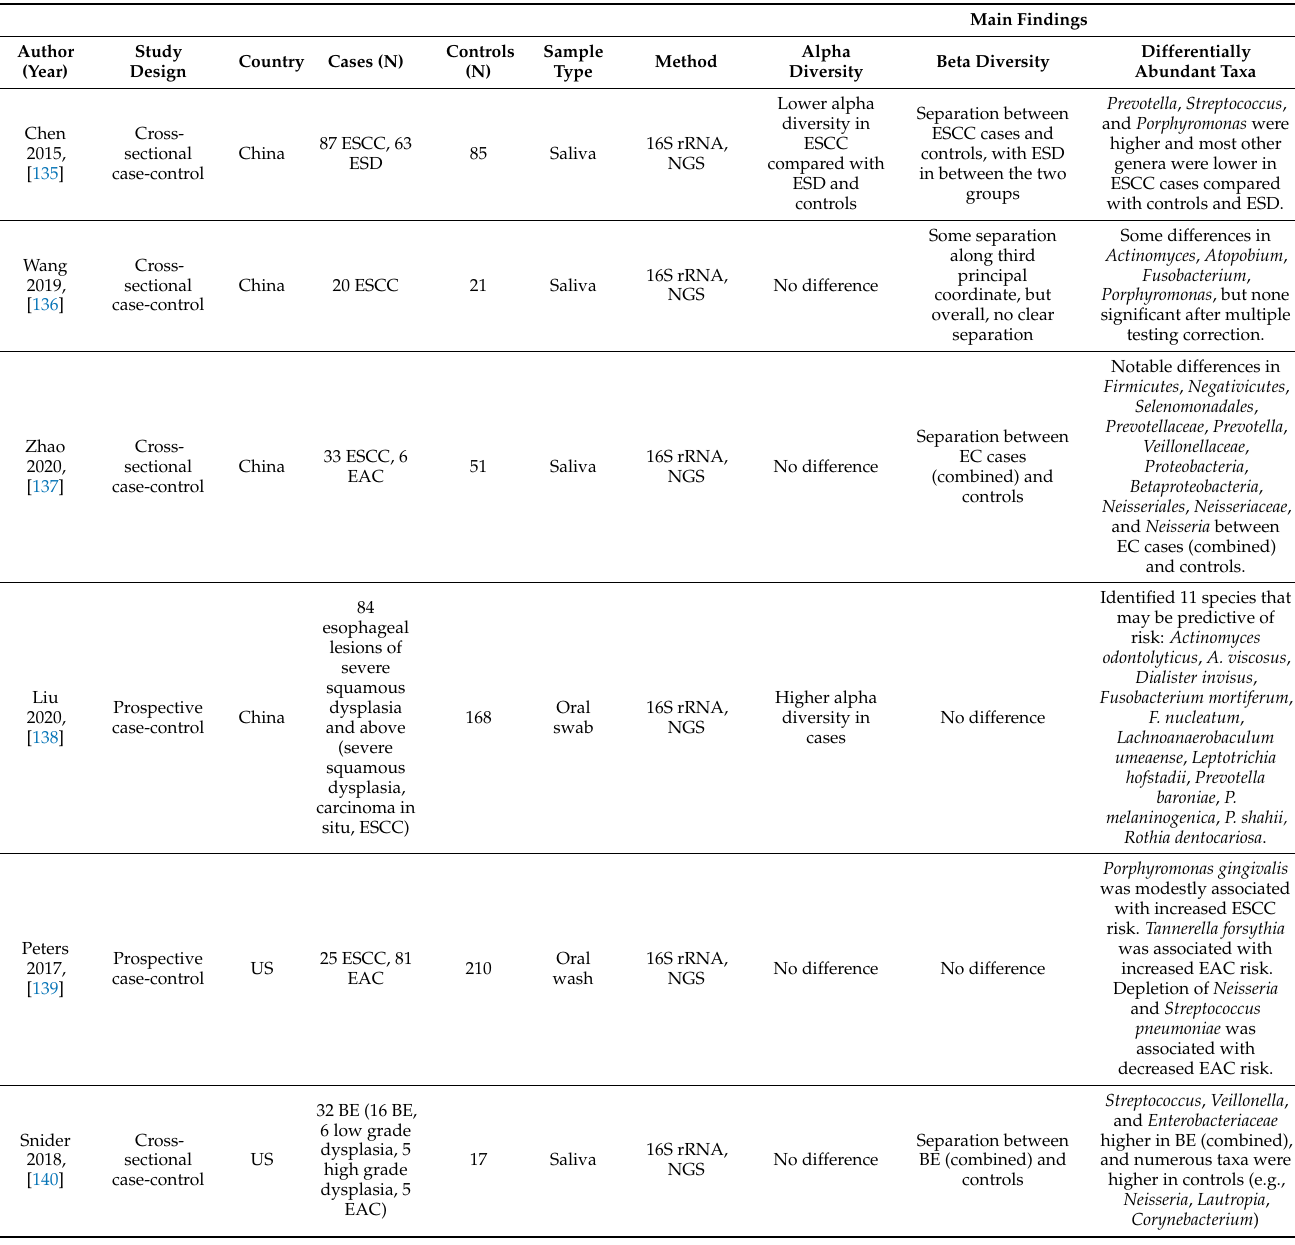
Table 1. Studies of the oral microbiome and esophageal